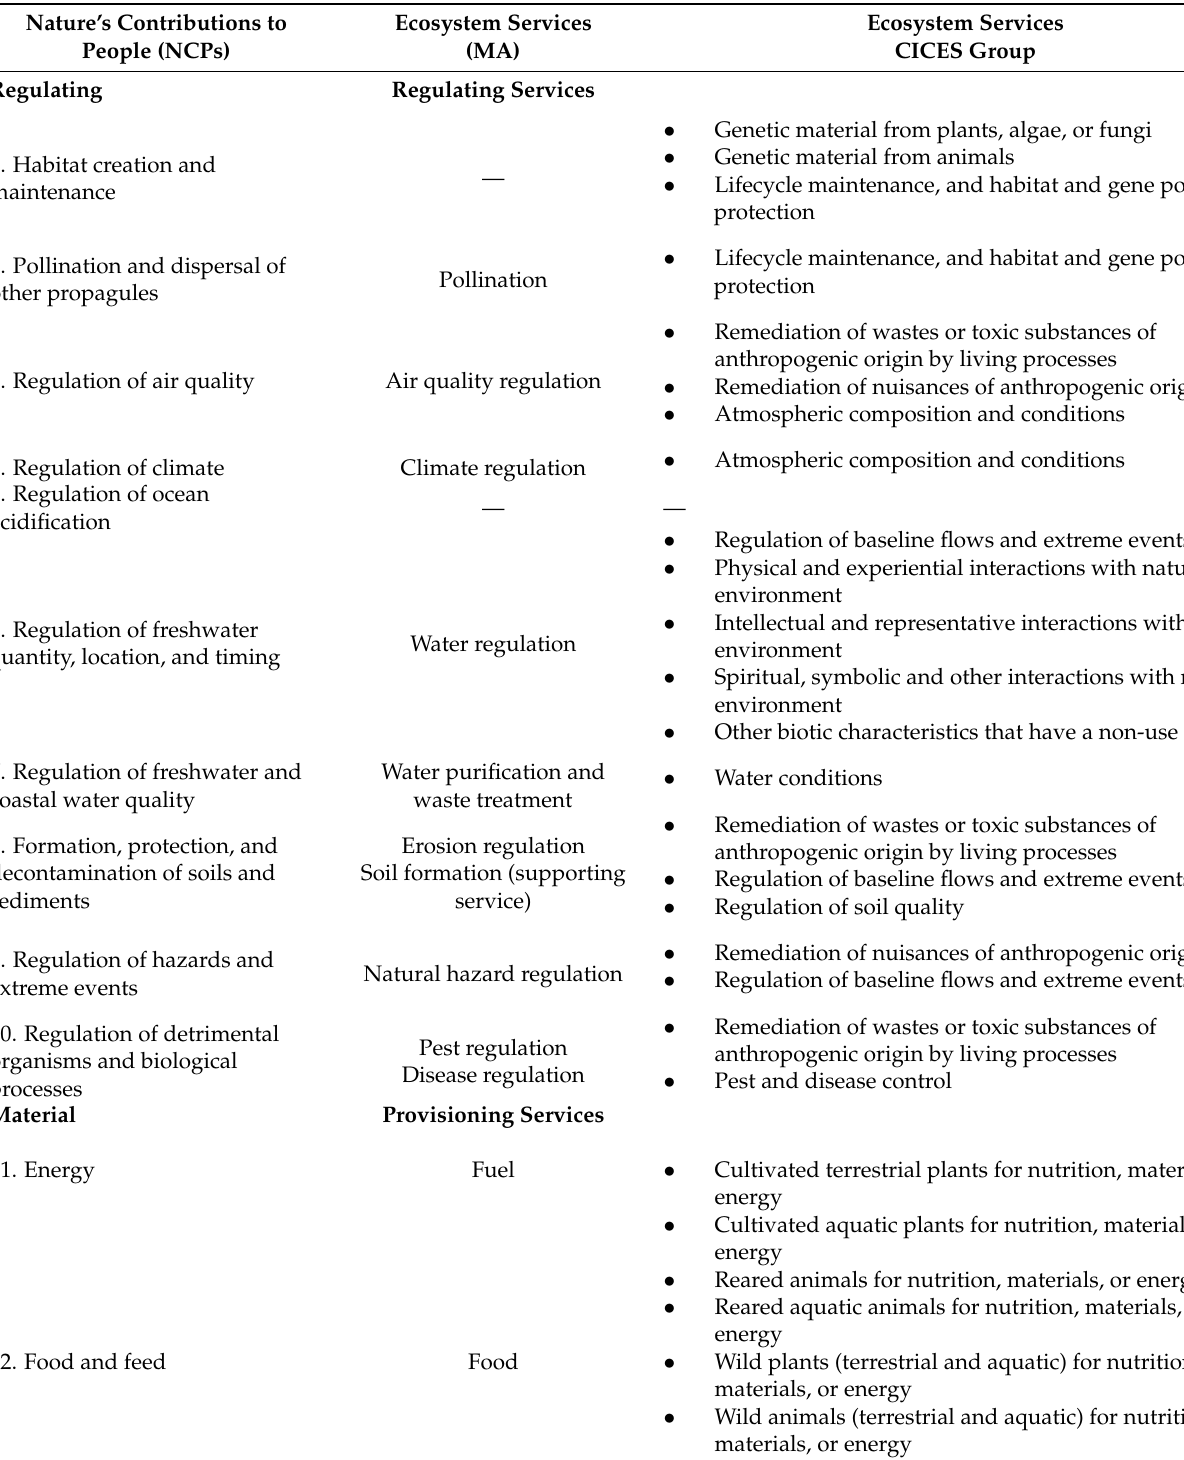
Table 1. List of NCPs alongside the corresponding ecosystem services from the Millennium Ecosystem Assessment and the CICES groups of ecosystem